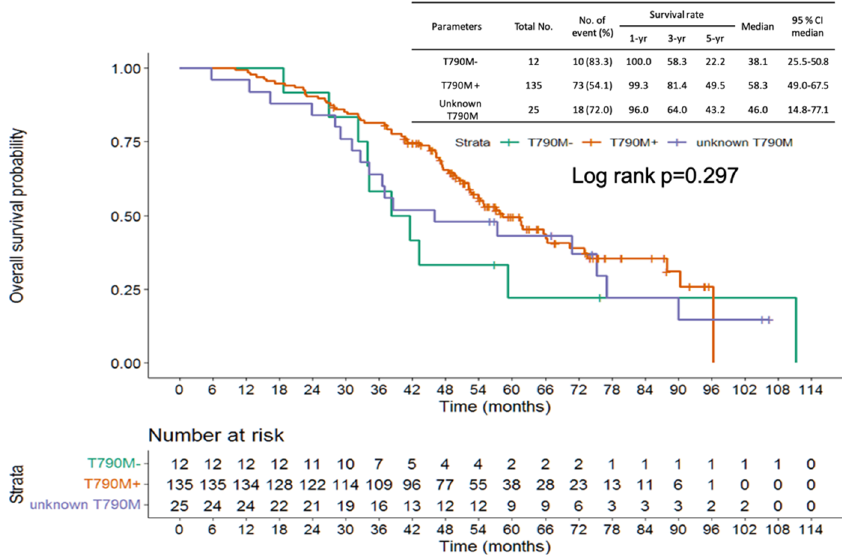
Figure 5. Overall survivals from frontline EGFR-TKIs based on T790M status.